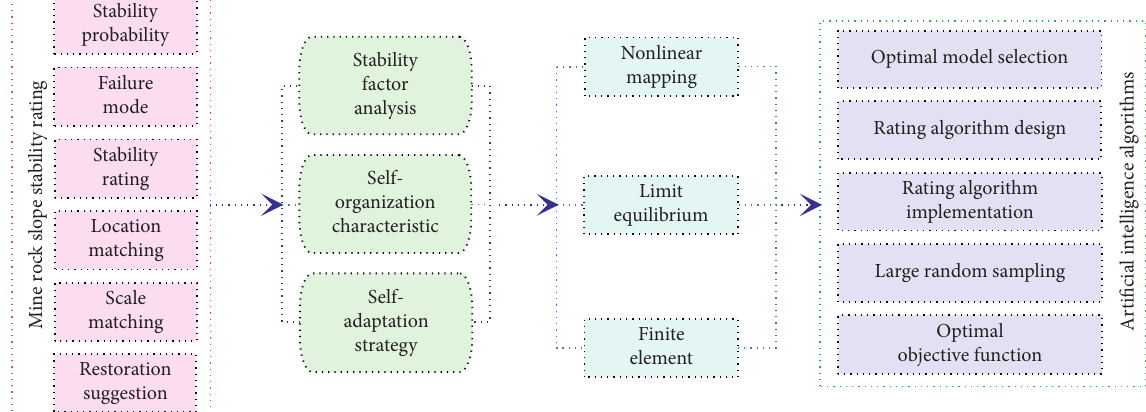
Figure 1: Analytical framework of stability rating of mine rock slope based on artificial